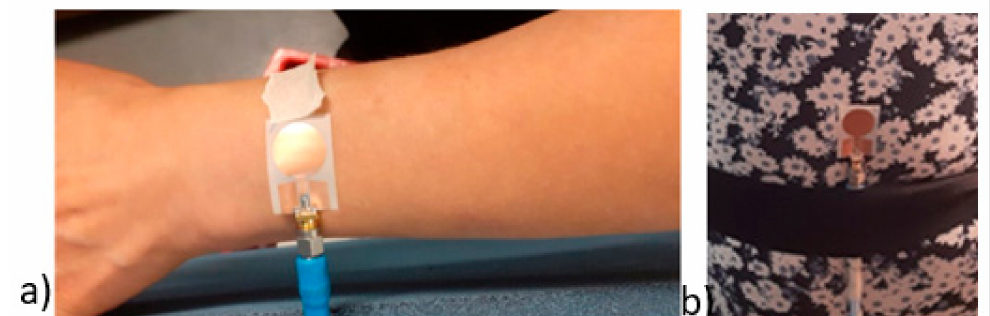
Figure 7. ( a ) Antenna located on the hand, ( b ) antenna located on the abdomen, both locations measured with and without the thin cloth between the antenna and the skin.